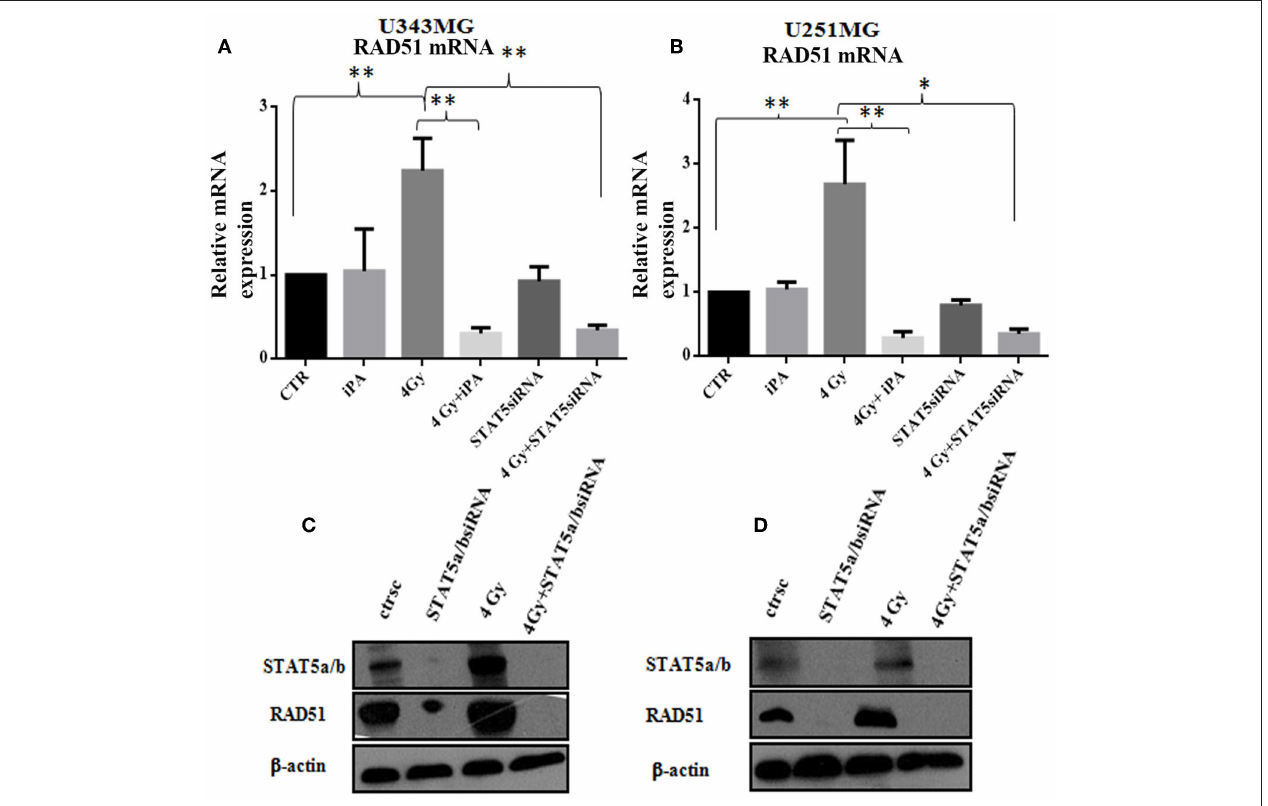
FIGURE 6 | Stat5a/b was inhibited by transfection with of STAT5a/b siRNA (siSTAT5a/b) in U343MG and U251MG. (A,B) Rad51 mRNA levels. Cells were exposed to iPA or transfected with STAT5a/b-siRNA for 48h followed by irradiation at 4Gy and collected for RT-PCR analysis of the Rad51/ β 2microglobulin mRNA ratios. Each value represents the mean ± SE for five independent experiments. Results are expressed as mean ± SD (ANOVA * p < 0.05, ** p < 0.01) compared with control values. (D,C) western blot analysis of Rad51 expression in U343MG and U251MG cells transfected with STAT5a/b-siRNA vs. control (scramble-siRNA, ctrsc) for 48h followed by irradiation at 4Gy. Effective genetic depletion of Stat5a/b are demonstrated by immunoblotting with anti-STAT5a/b (C,D) . β -actin was used as loading